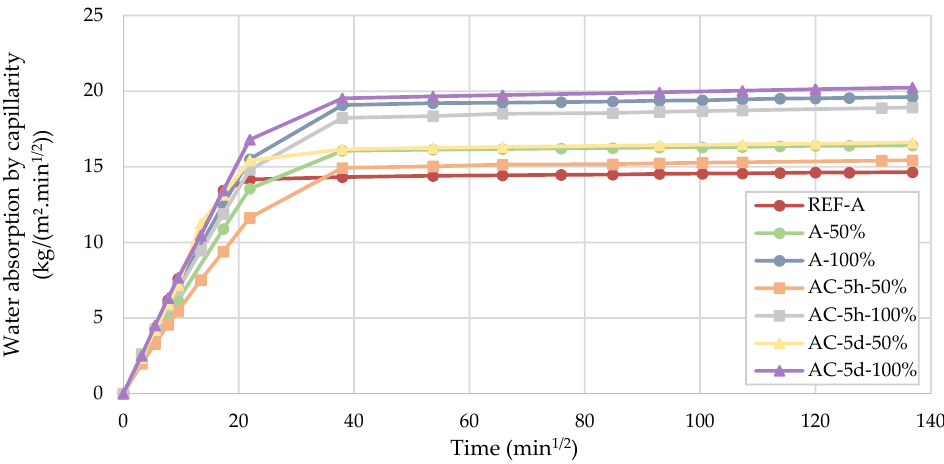
Figure 9. Capillarity water absorption curves.